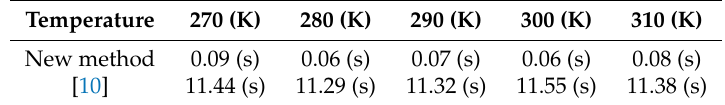
Table 1. The computation time of magnetocaloric material (MCM) properties in the numerical model.